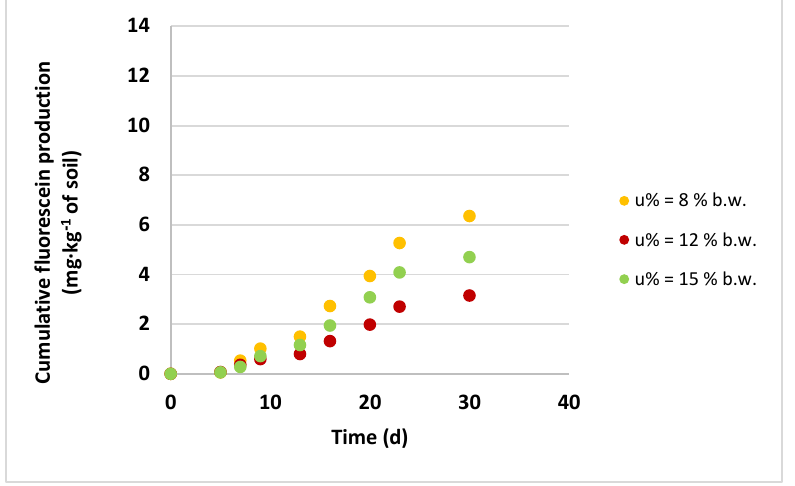
Figure 4. Cumulative fluorescein production by microcosms with C/N = 300.